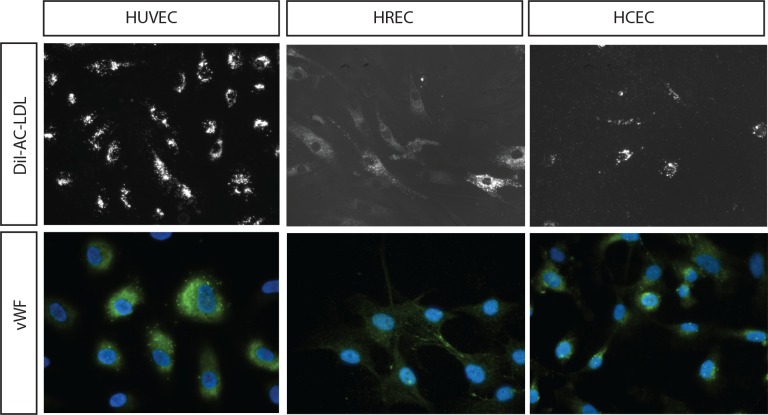
EC Marker staining of the EC cells used.A (Upper panels). Uptake of DiI labeled Acetyl-LDL in the EC lines (HUVEC, HREC and HCEC); B (lower panels). Staining of the EC lines with antibody to EC marker vWF.